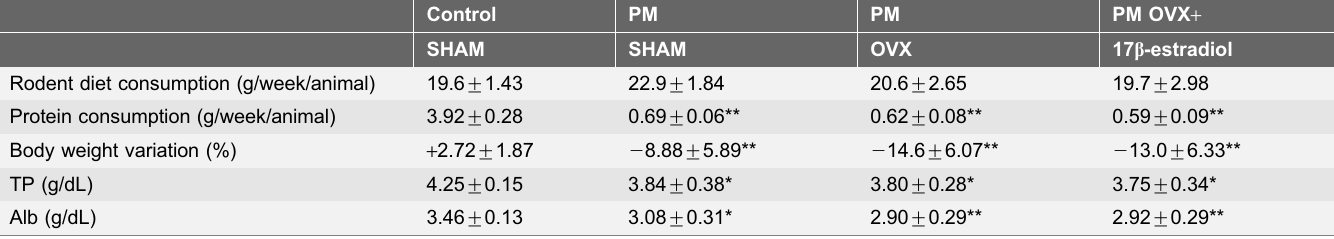
Table 3. Rodent diet consumption, protein consumption, body weight variation, TP and Alb among the four